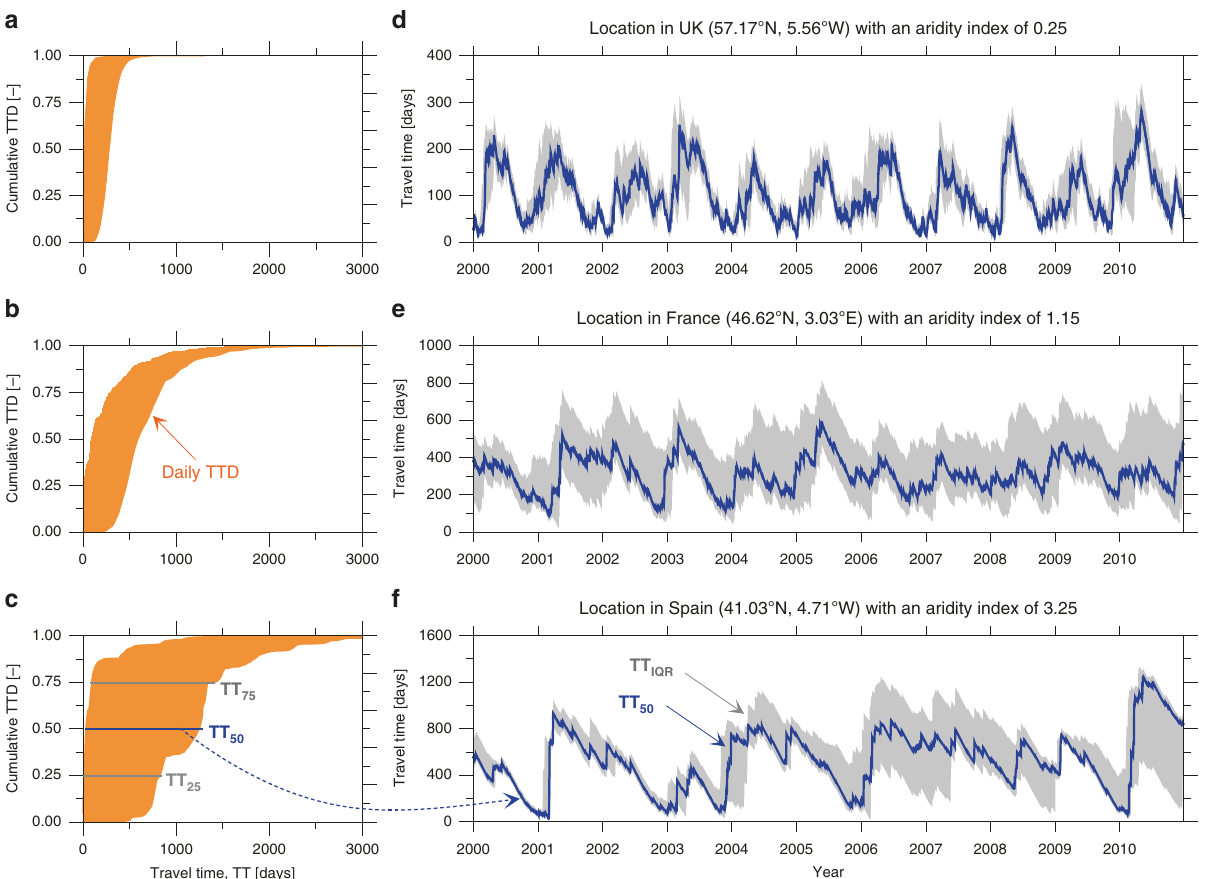
Fig. 1 Transient features of the hydrologic transport dynamics. Illustration of the daily travel-time distributions ( a – c ), and the corresponding temporal evolution of the daily median TT 50 and interquartile ranges TT IQR ( d – f ) for three distinct locations in the UK, France, and Spain representing the sub-humid, humid or transitional, and semi-arid hydroclimatic settings across Europe,